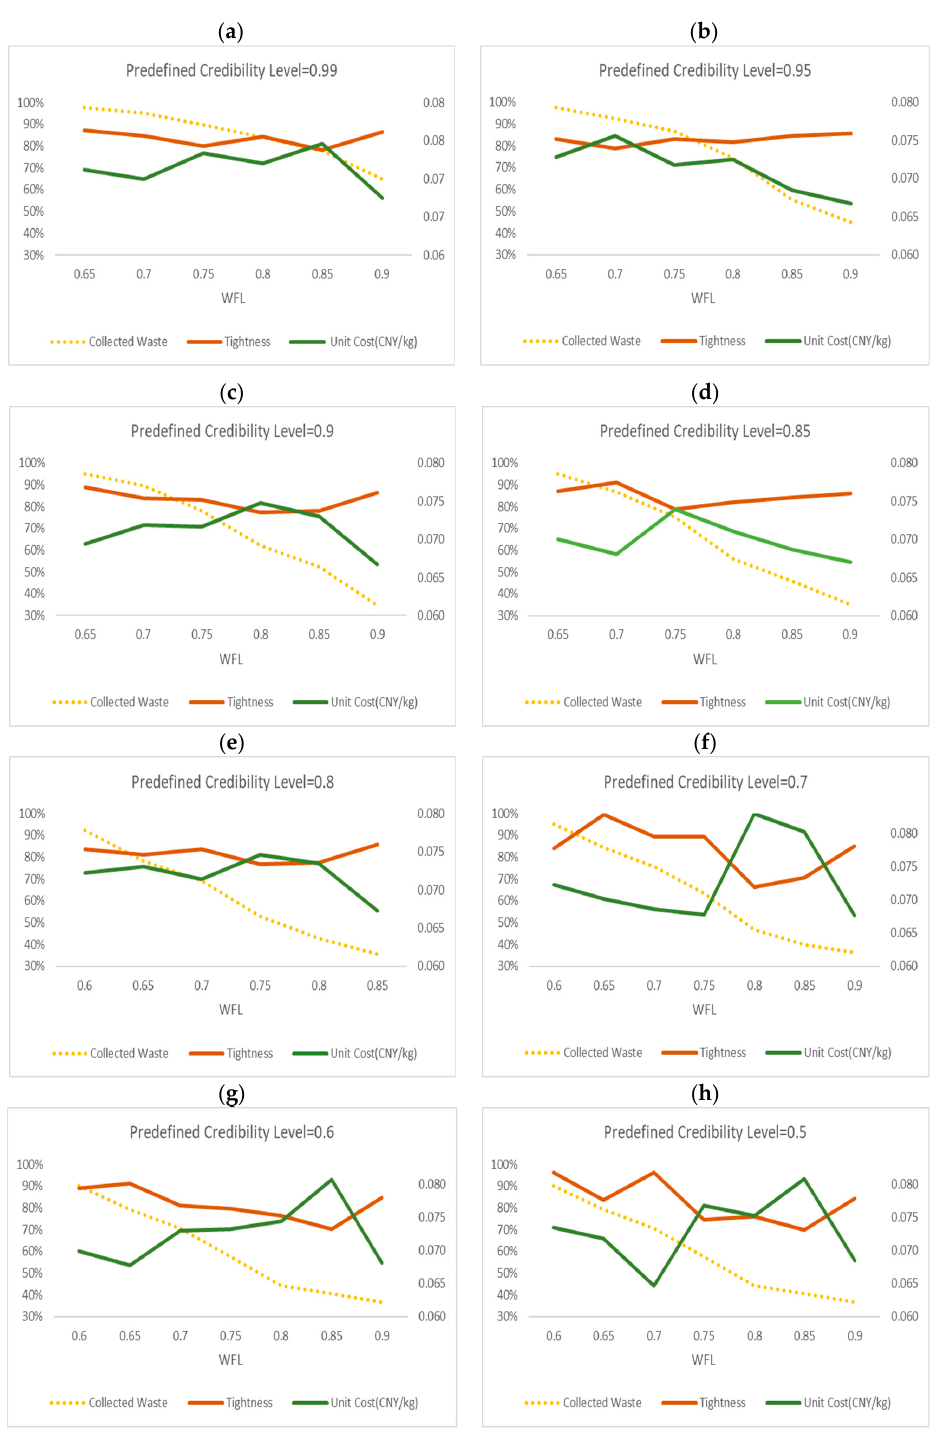
Figure 6. The changes of tightness, unit cost and collected waste percentage under different γ .